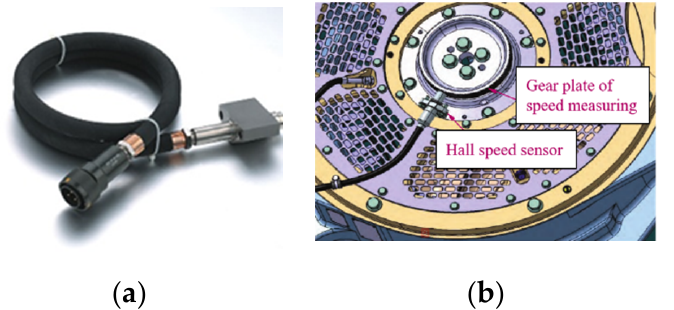
Figure 3. Wheel Hall speed sensor and installation example: ( a ) wheel Hall speed sensor; ( b ) installation example.